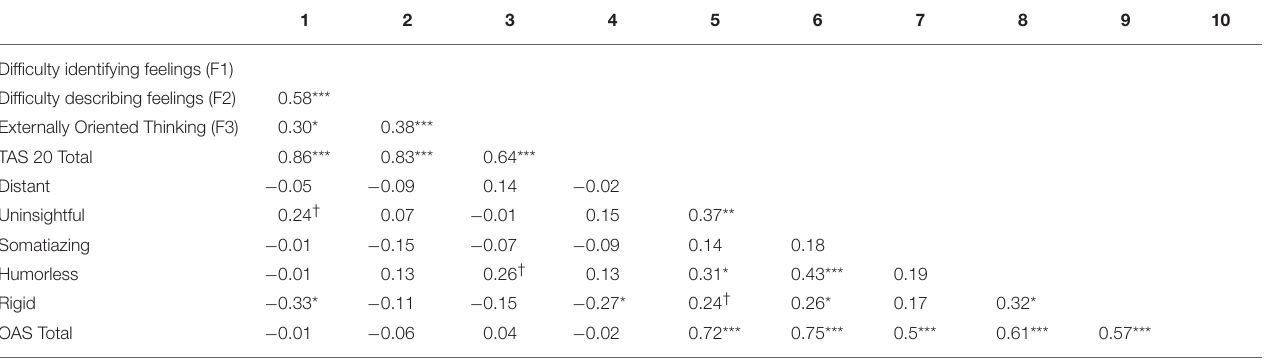
TABLE 3 | Partial correlations between self-reported and observed alexithymia measures controlling for gender and